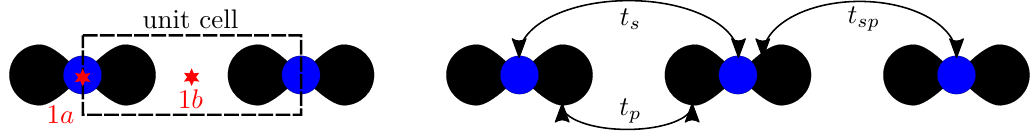
Figure 5: Schematic representation of the Rice-Mele model, where the basis formed by s (blue spheres) and p -orbitals (black) is shown. The chosen unit cell is indicated x with dashed